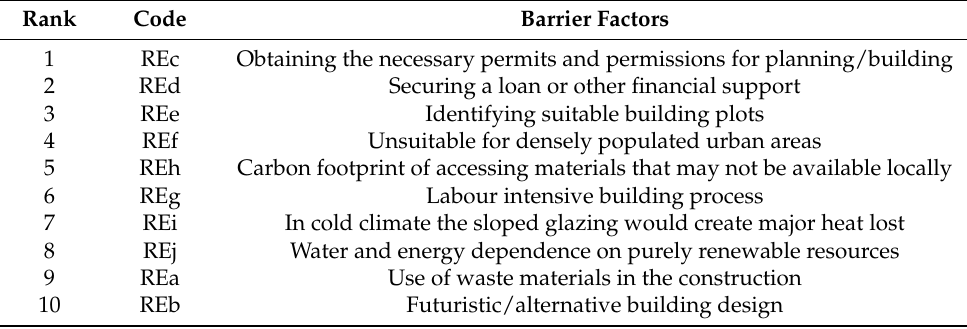
Table 7. List of barrier factors in ranked